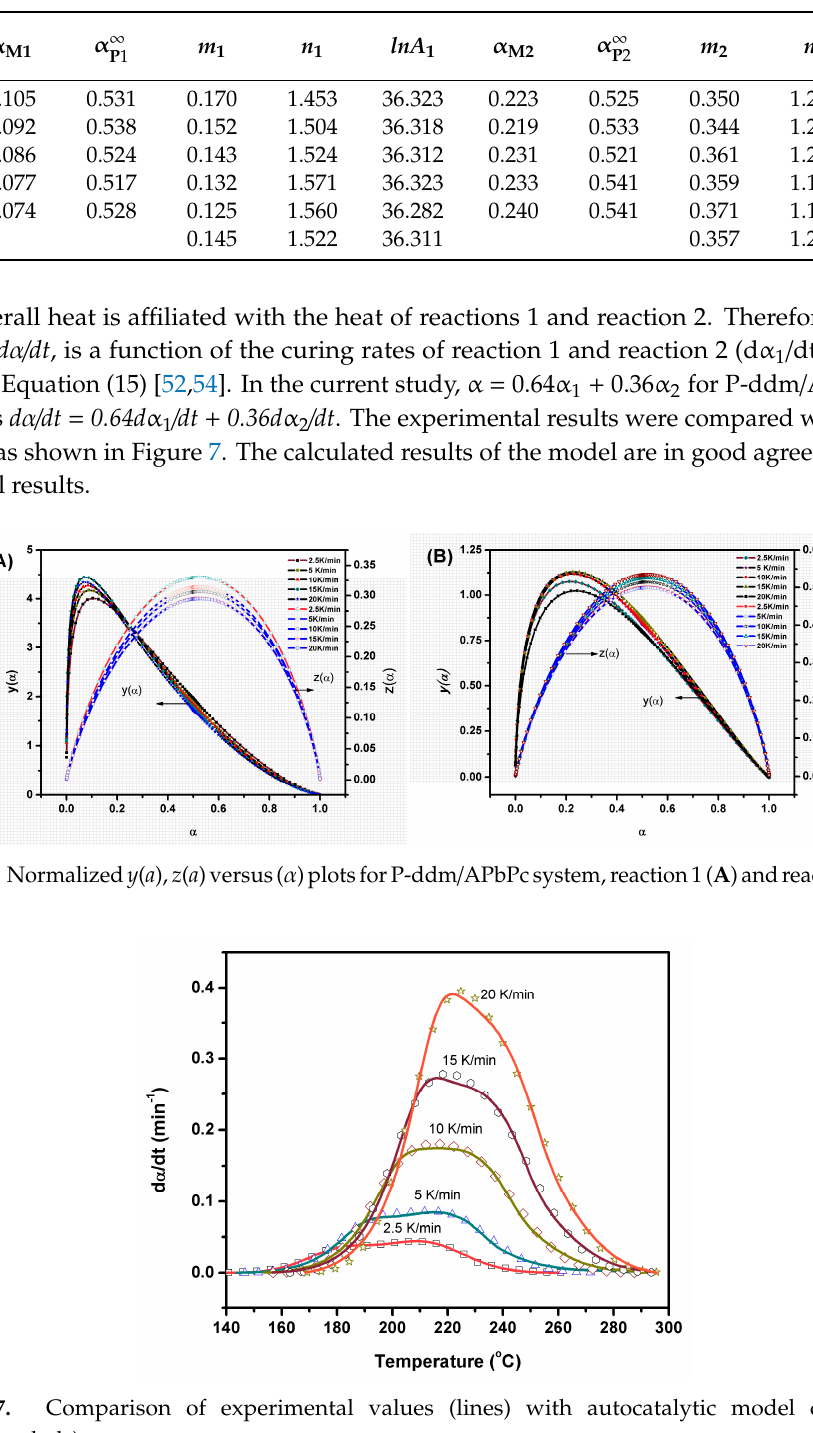
Figure 7. Comparison of experimental values (lines) with autocatalytic model calculated values (symbols).